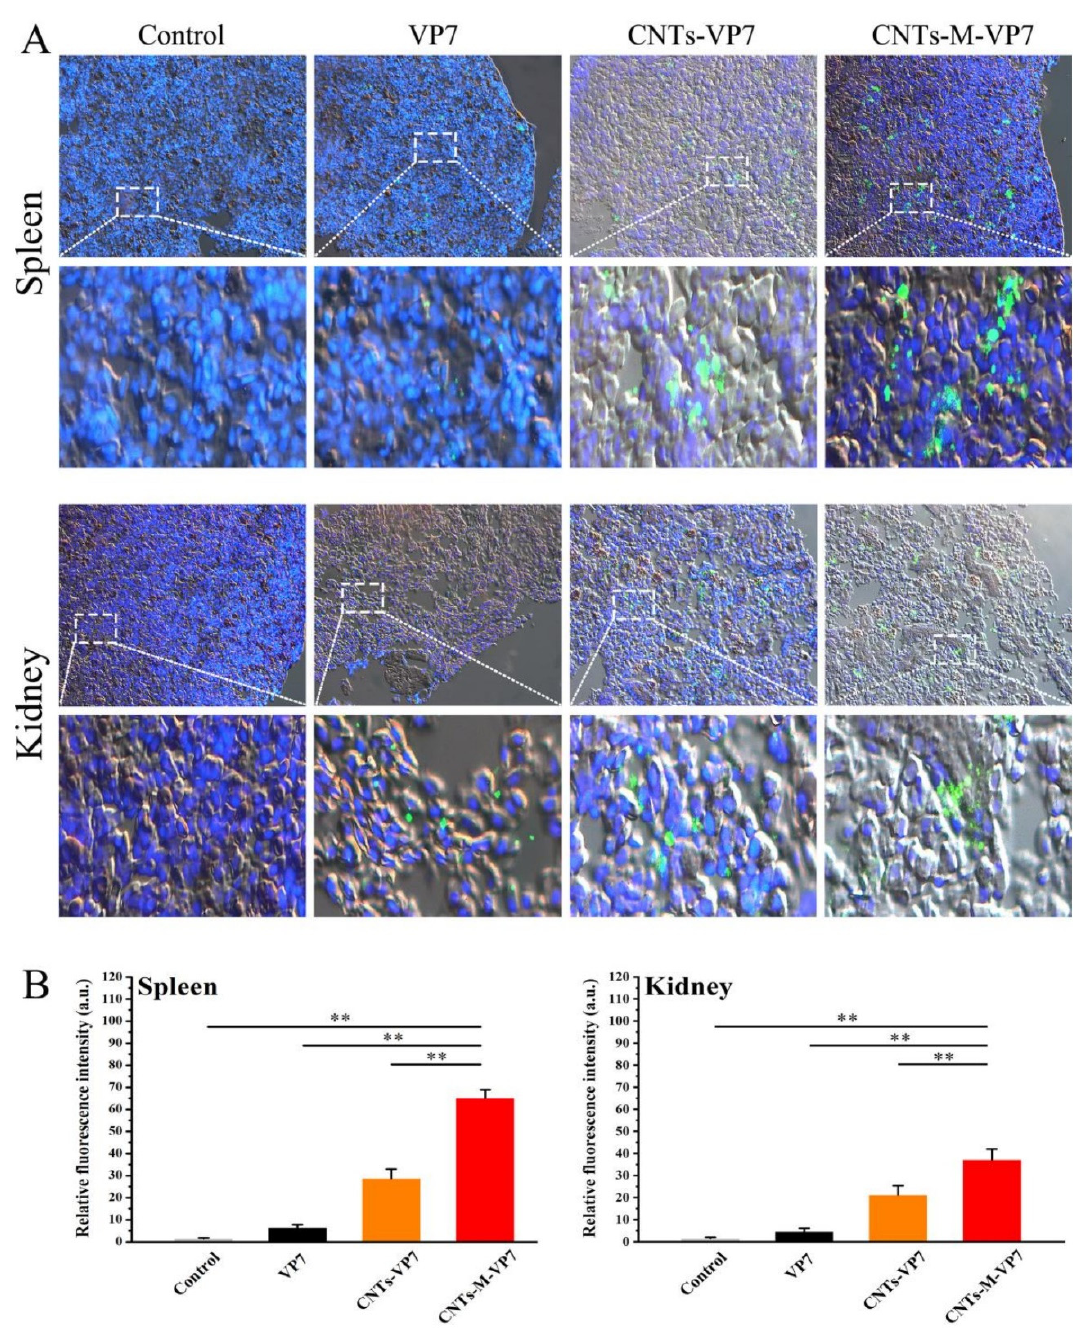
Figure 3. Uptake of nanovaccine in fish tissues. ( A ) The immunofluorescence images of fish tissues (spleen and kidney) after incubated with vaccines (VP7, CNTs-VP7, and CNTs-M-VP7), respectively. The vaccines were labeled with FITC (green channel); The cell nucleus was labeled with DAPI (blue channel). ( B ) Mean fluorescence intensity of vaccine in fish treated with VP7 (black column), CNTs-VP7 (Orange column), CNTs-M-VP7 (Red column). Free FITC treatment was conducted as the control (light grey column). Data are presented as the mean ± SD. p values were calculated by Student’s t -test (** p < 0.01, * p < 0.05).